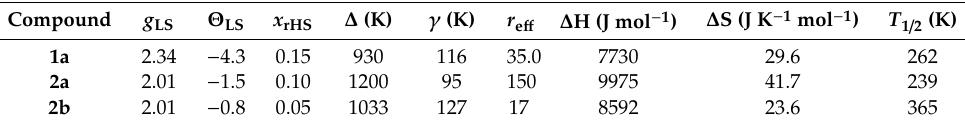
Table 2. The magnetic parameters for 1a , 2a , and 2b a.